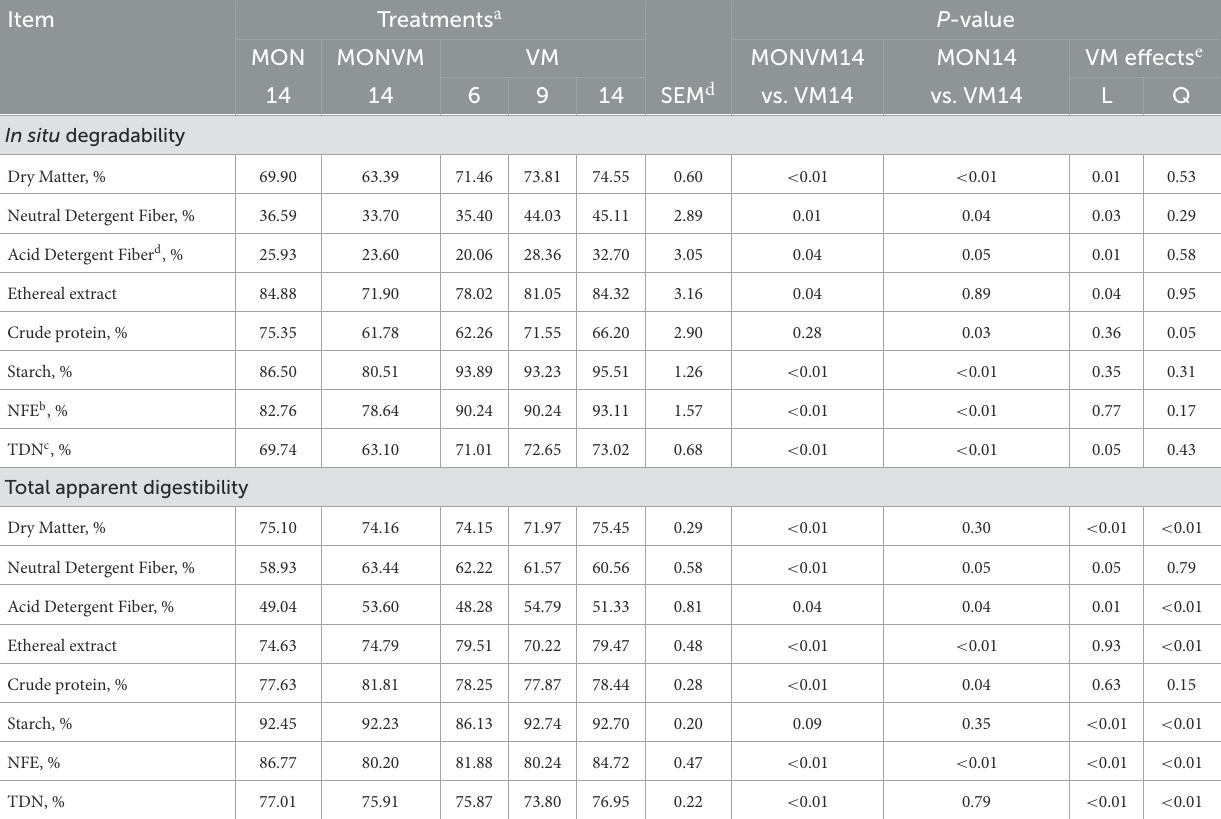
a MON14: 27 mg of MON/kg of DM and adaption for 14 d; MON + VM14: 27mg of MON/kg of DM and 25 mg of VM/kg of DM and adaption for 14 d; VM14: 25 mg of VM/kg of DM and adaptionfor14d;VM9:25mgofVM/kgofDMandadaptionfor9d;VM6:25mgofVM/kgofDMandadaptionfor6d; b Nitrogenfreeextract; c Totaldigestiblenutrients; d StandardErrorof Mean;5L:linearandQ:quadraticresponsesfortheeffectofadaptationlengthincattlefedonlyVM.